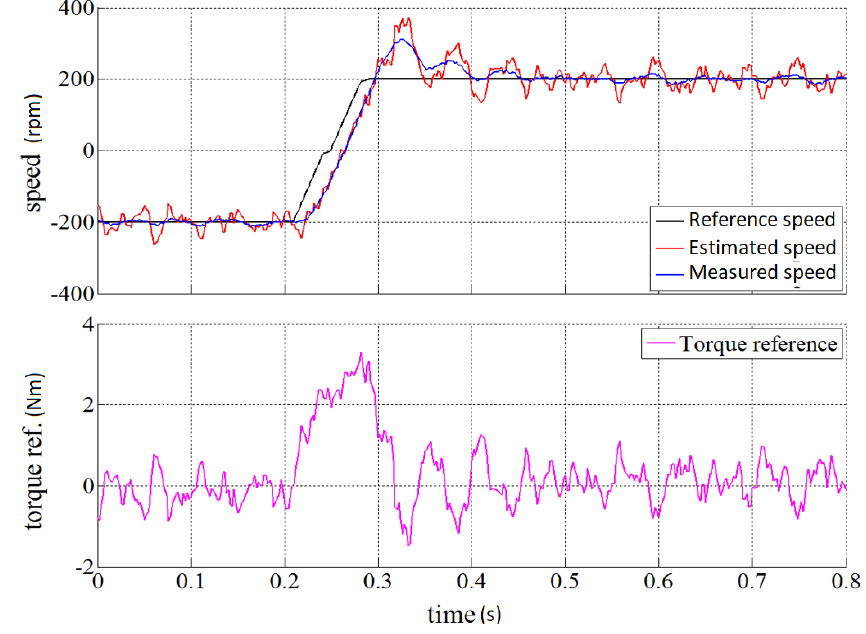
Figure 18. Motor #1: Increased bandwidth sensorless speed control (MTPA), –200 to + 200 rpm inversion, proposed (self-adaptation) rotating voltage injection and 𝑖 𝑖1 regulation (150 mA), no load.